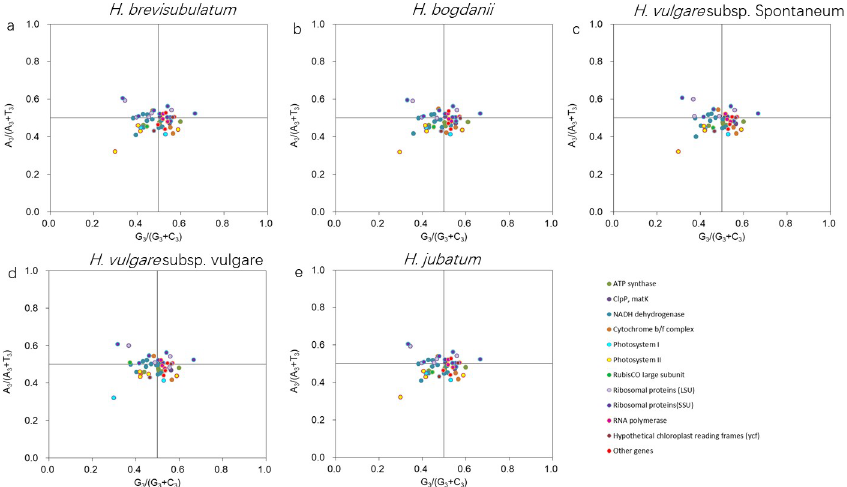
Fig 2. PR2 analysis for genes in the cp genomes of five Hordeum species. A 3 , T 3 , C 3 and G 3 represent nucleotide A, T, C and G content at the third position of synonymous codons,